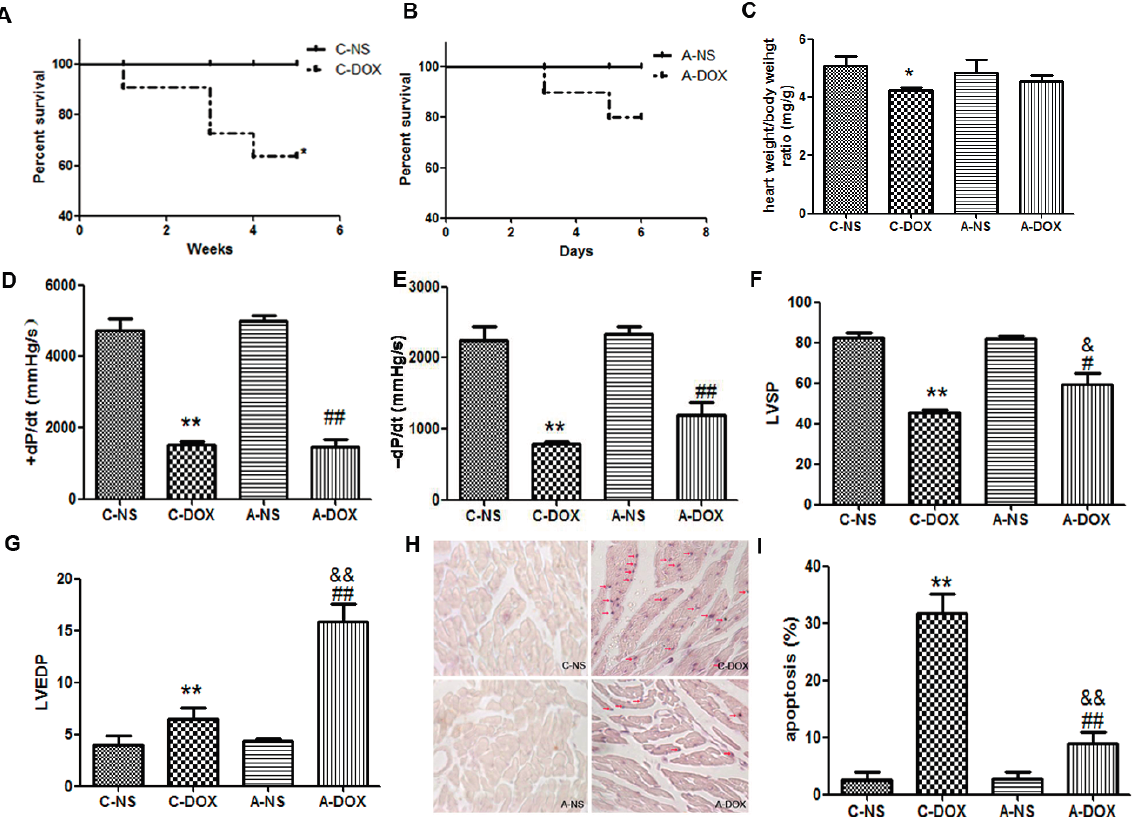
Figure 2B, exposure of cardiac myocytes to DOX at doses ranging from 0–4 µM for 24 h resulted in a significantly dose-dependent increase in miR-21 expression level in H9C2 cells ( p < 0.01, n = 3).